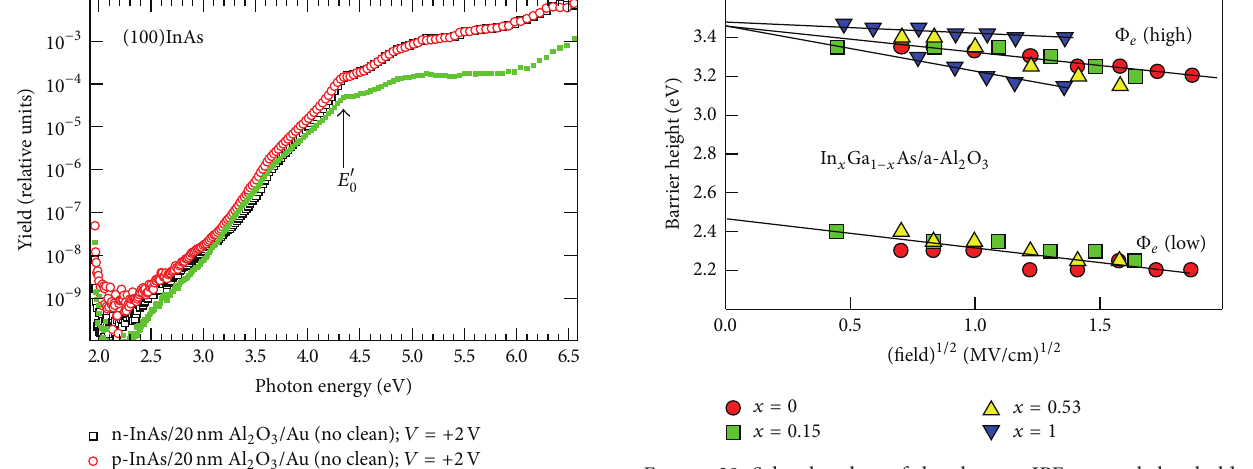
Figure 29: Schottky plots of the electron IPE spectral thresholds observed in samples with Al 2 O 3 insulator and different content 𝑥 of In in the semiconductor substrate. The “high” spectral threshold corresponds to the energy barrier between the top of the In 𝑥 Ga 1−𝑥 As VB and the bottom of the deposited oxide CB. The “low” barriers stem from the electron IPE mediated by the narrow-gap In 𝑥 Ga 1−𝑥 As “native” oxide present at the interface. Lines guide the eye.